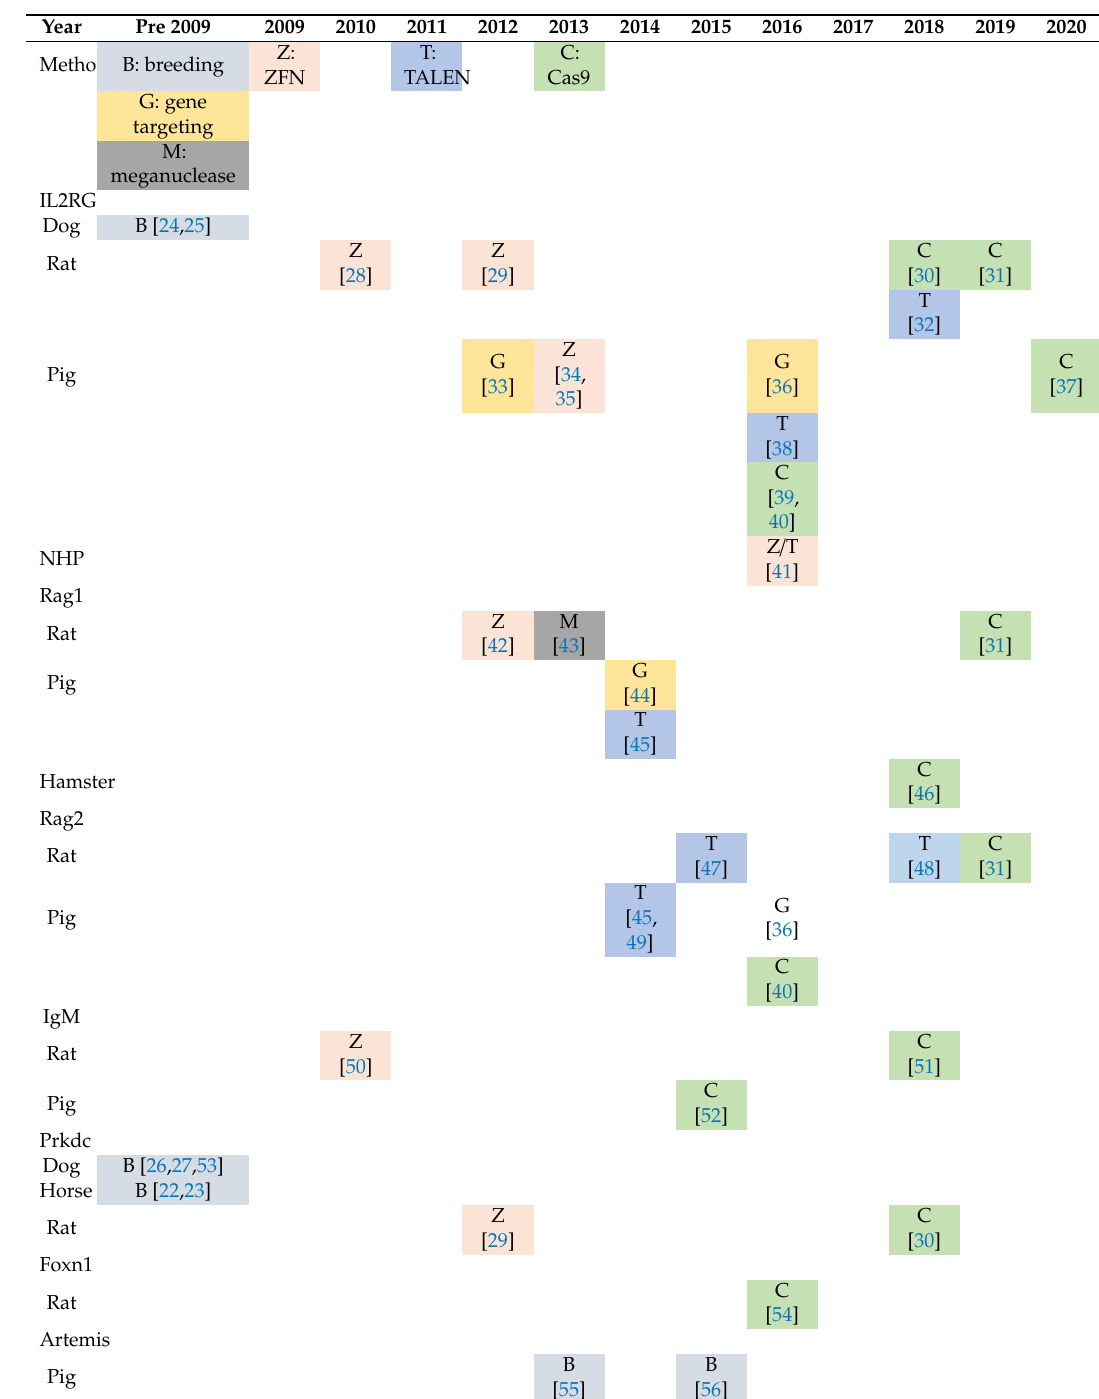
Table 1. Production of immunodeficient (ID) non-murine animal models (except rabbits). The “Method” row indicates the debut year of the method. G: gene targeting refers to the conventional gene editing nuclease-free, homologous recombination-based gene targeting method. M: meganuclease refers to an I-CreI based